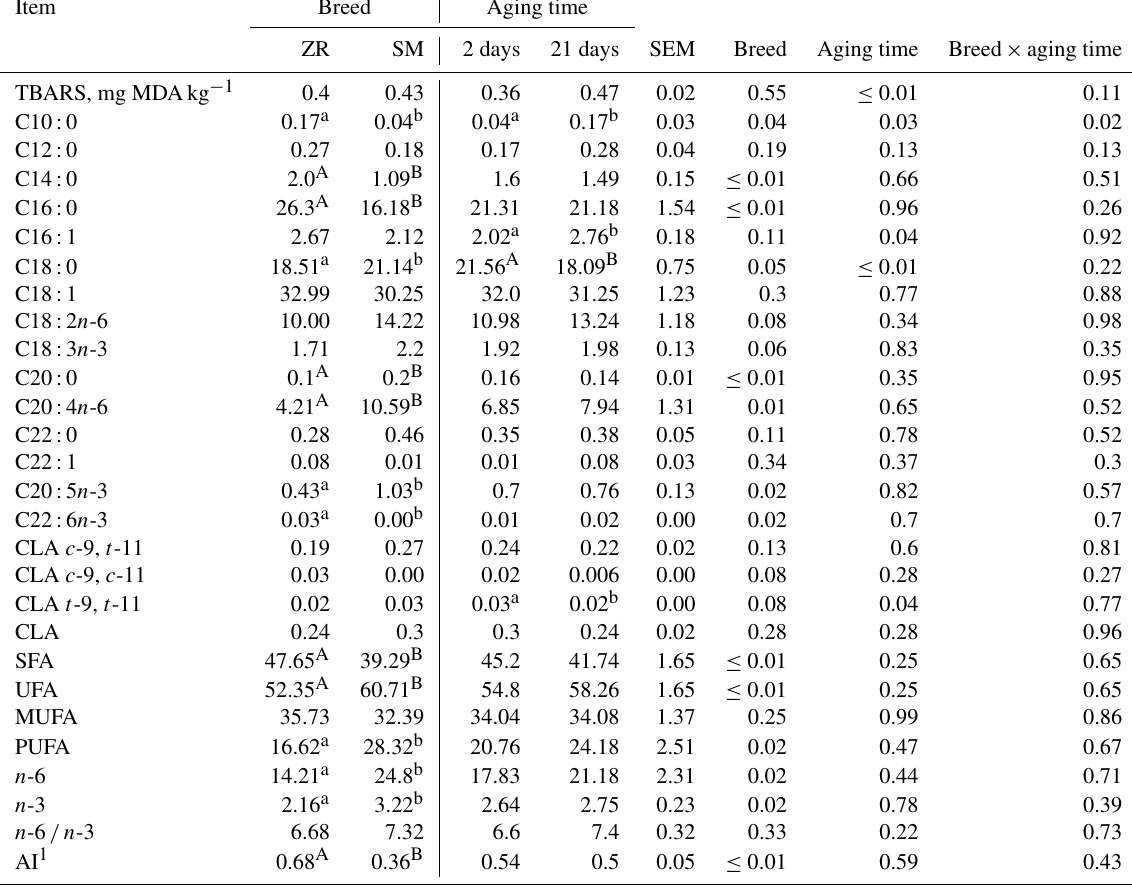
Table 3. Effect of breed and meat aging time on fatty acid profile of longissimus dorsi muscle fat and TBARS. Item